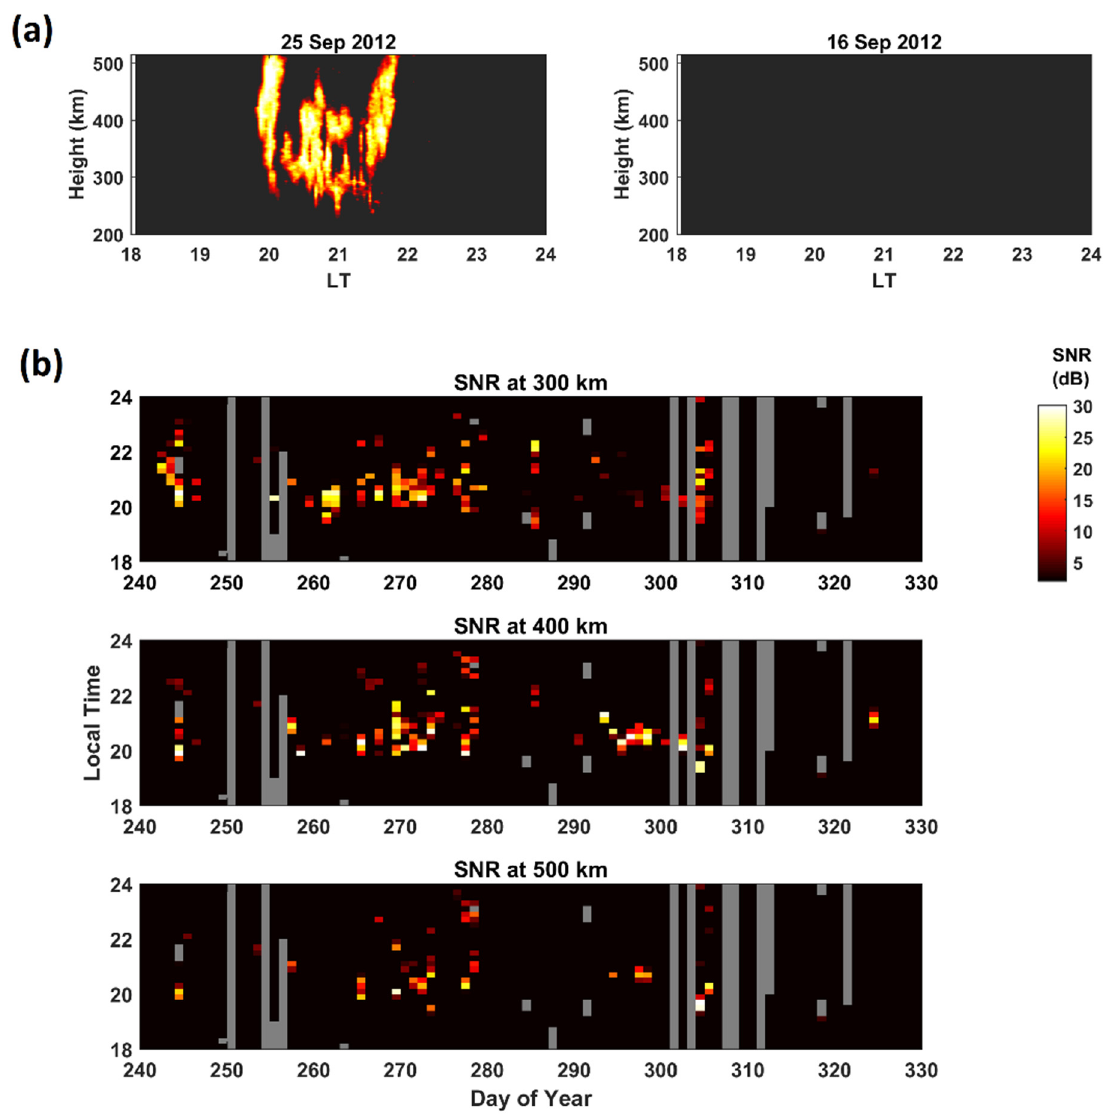
Figure 1. ( a ) Height–Time–SNR maps of night-time EAR observation recorded on 25 September 2012 and 16 September 2012. Radar plumes representing plasma bubbles were observed on 25 September, while on 16 September plasma bubbles were not observed. ( b ) Nocturnal (18–24 LT) SNR variability during days 240–330 in 2012. Here, the grey region indicates the data gap.